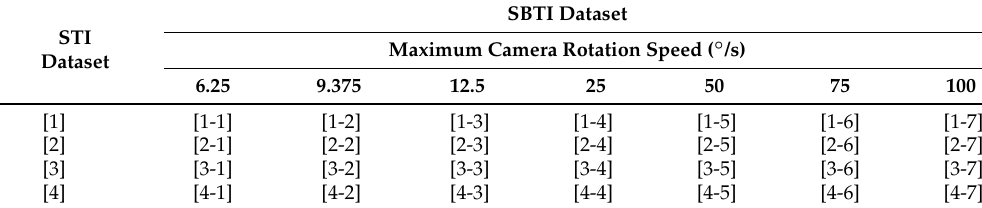
Table 3. Configuration of SBTI